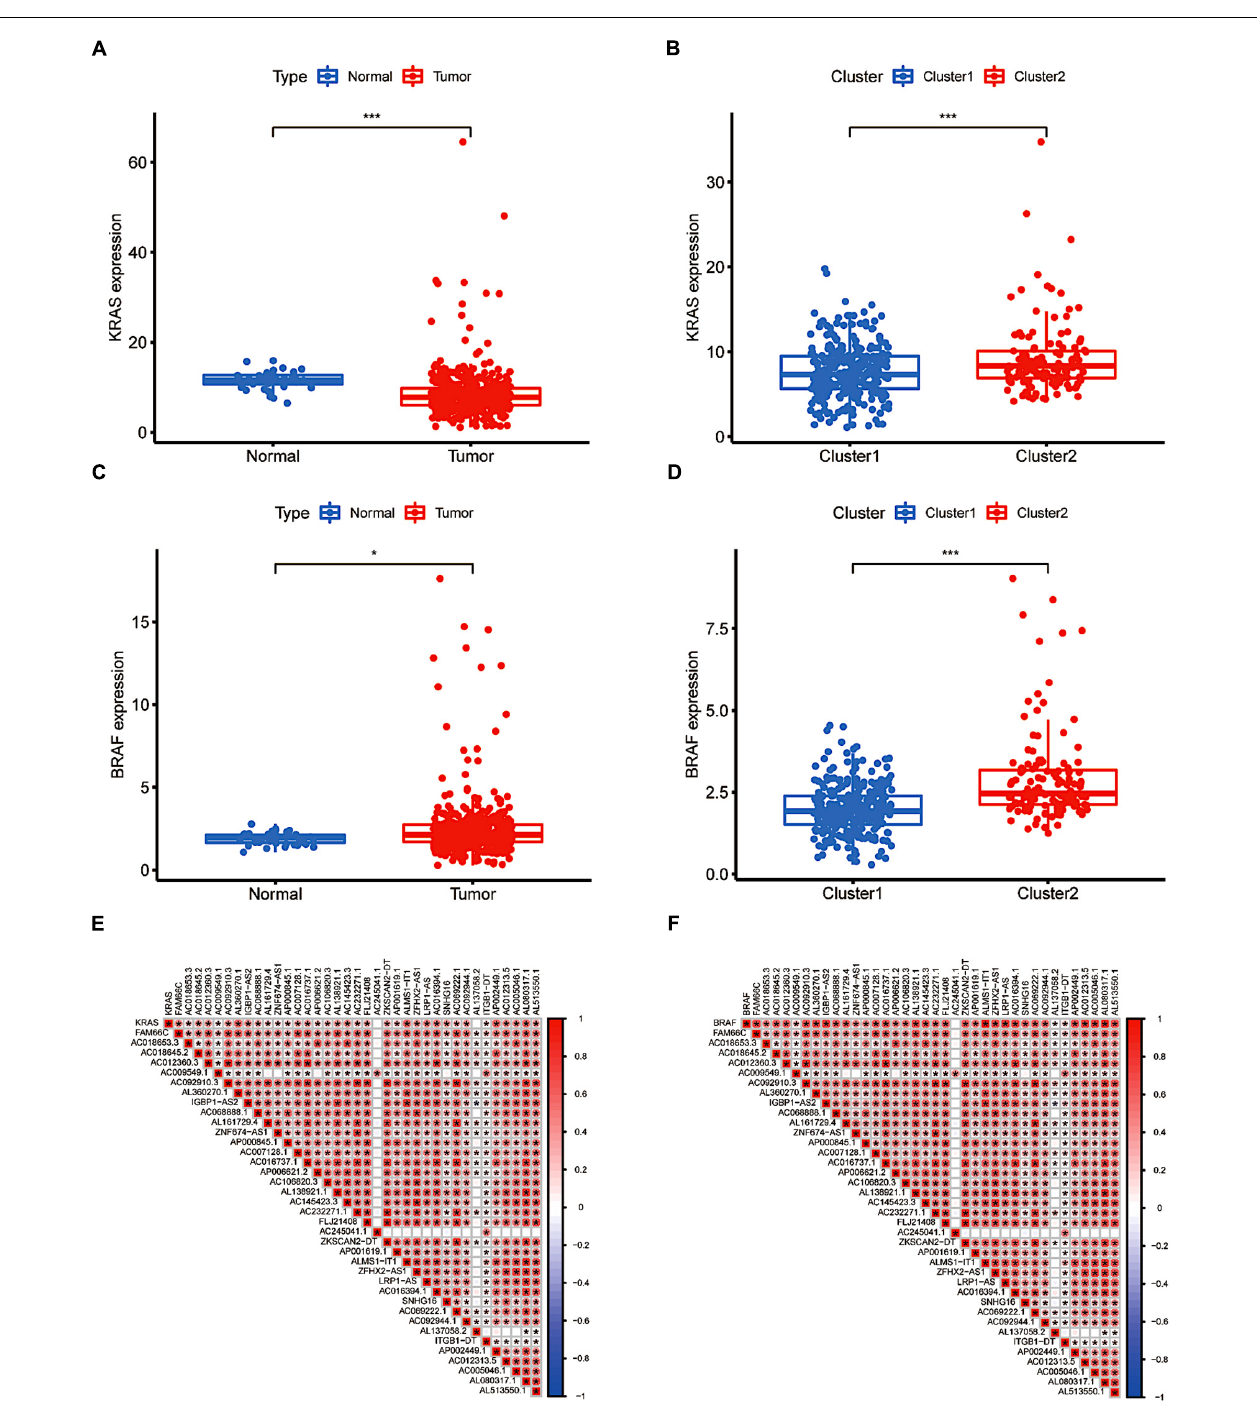
FIGURE 3 | The differential expression and relevance of KRAS and BRAF genes. (A) KRAS downregulation in CRC. (B) The expression level of KRAS in cluster 1/2 subtypes. (C) BRAF upregulation in CRC. (D) The expression level of BRAF in cluster 1/2 subtypes. (E,F) The correlation of KRAS and BRAF with lncRNAs with m6A methylation. * P < 0.05; ** P < 0.01; *** P < 0.001.